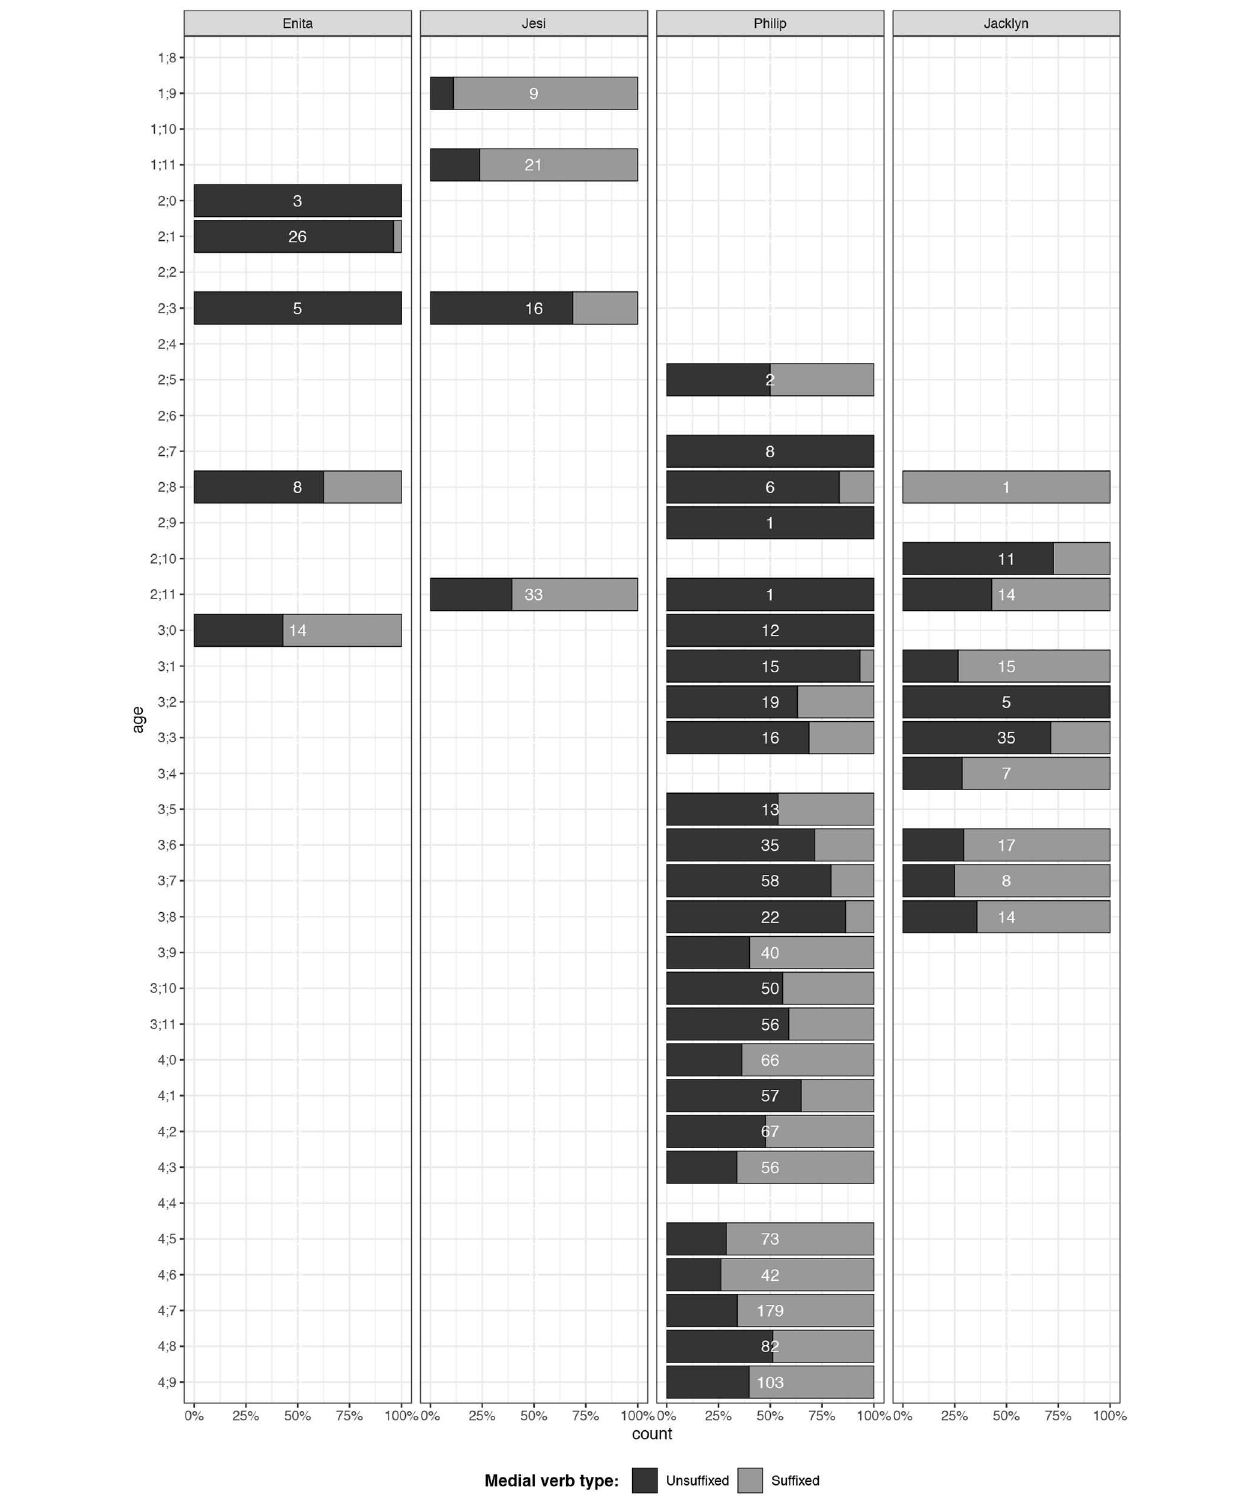
FIGURE 7 | Incidence of presence vs. absence of suffixes on Medial verbs used by the children.